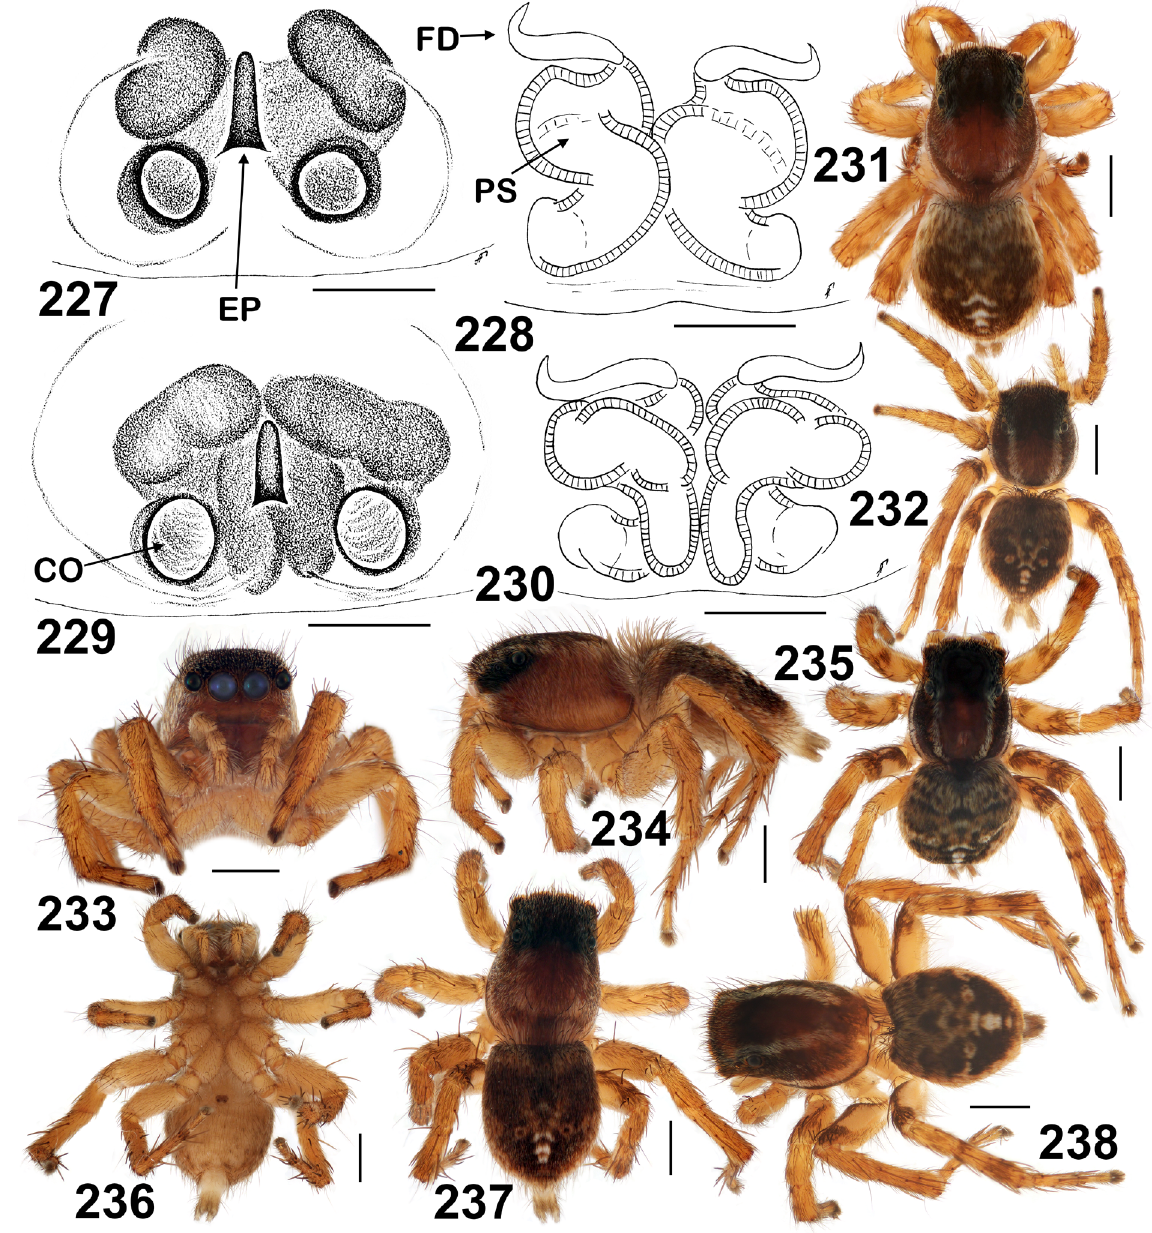
Figs 227–238. Stenaelurillus guttiger (Simon, 1901), ♀♀ . 227 , 229 . Epigyne, ventral view. 228 , 230 . Spermathecae, dorsal view. 231 – 238 . General appearnce. Specimens: 227–228, 235, 238 from South Africa (Ndumo GR; NCA 2006/1275); 229–230, 232 from South Africa (Kruger NP, Satara; NCA 2008/2001); 231 from South Africa (Kruger NP, Pafuri; NCA 2007/2474); 233–234, 236–237 from South Africa (Kruger NP, Oliphants; NCA 2009/3738). Scale bars: 227–230 = 0.1 mm; 231–238 = 1